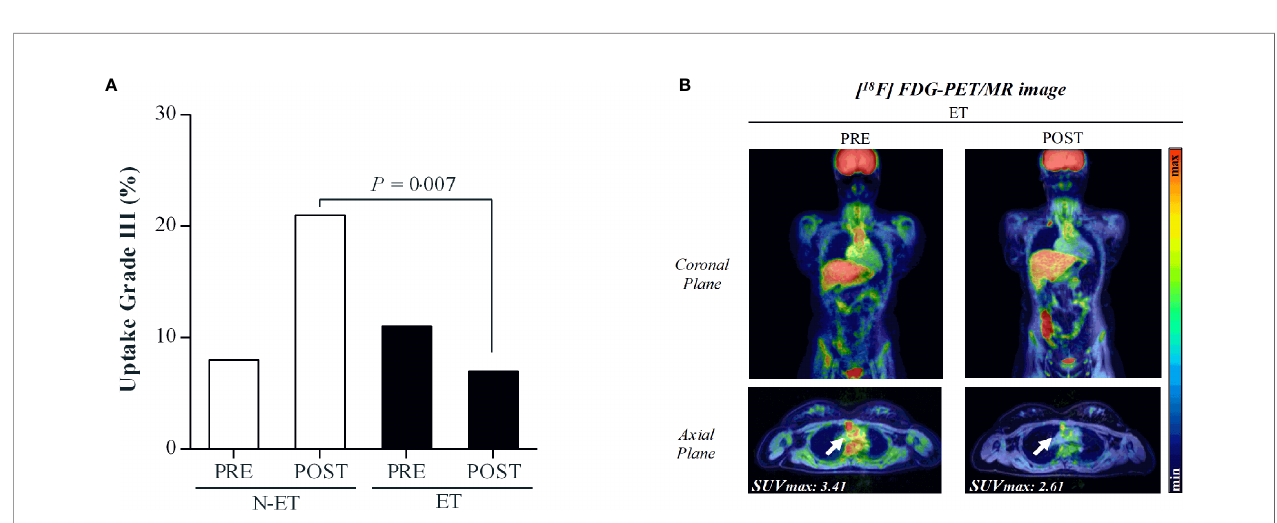
FIGURE 3 | Panel (A) : Distribution of vessel segments in grade III, representing severe in fl ammation. P =0.007 for between-group comparison at POST. Panel (B) : Illustrative case of a 20-year-old patient with childhood-onset Takayasu Arteritis. The [ 18 F] FDG PET/MR imaging revealed grade III in fl ammation in the ascending aorta artery before the intervention (SUV max =3.41). Following the exercise training program, the uptake decreased to grade II (SUV max =2.61).